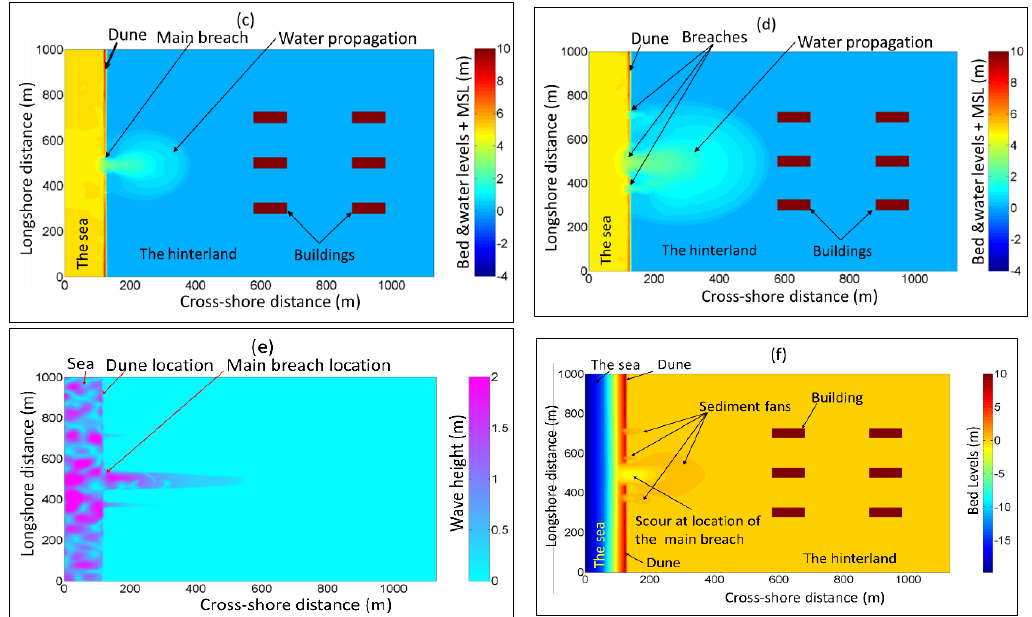
Figure 12 . Application of XBeach for the 2D synthetic coastal zone in Figure 3, showing: ( a ) 3D view of the bed levels and the buildings, ( b ) plan view of the bed levels and building locations, ( c ) main breach location and inundation extent at t = 45 min, ( d ) locations of breaches and inundation extent at the storm end (t = 60 min), ( e ) distribution of the wave height over the model domain at the storm end and ( f ) morphological changes at the storm end.